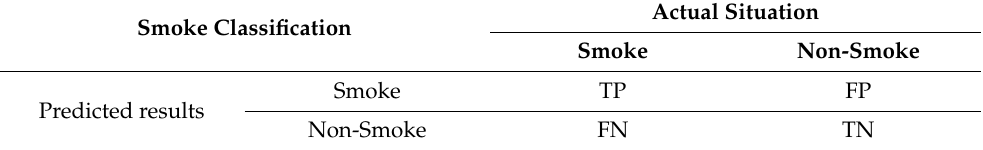
Table 3. Confusion